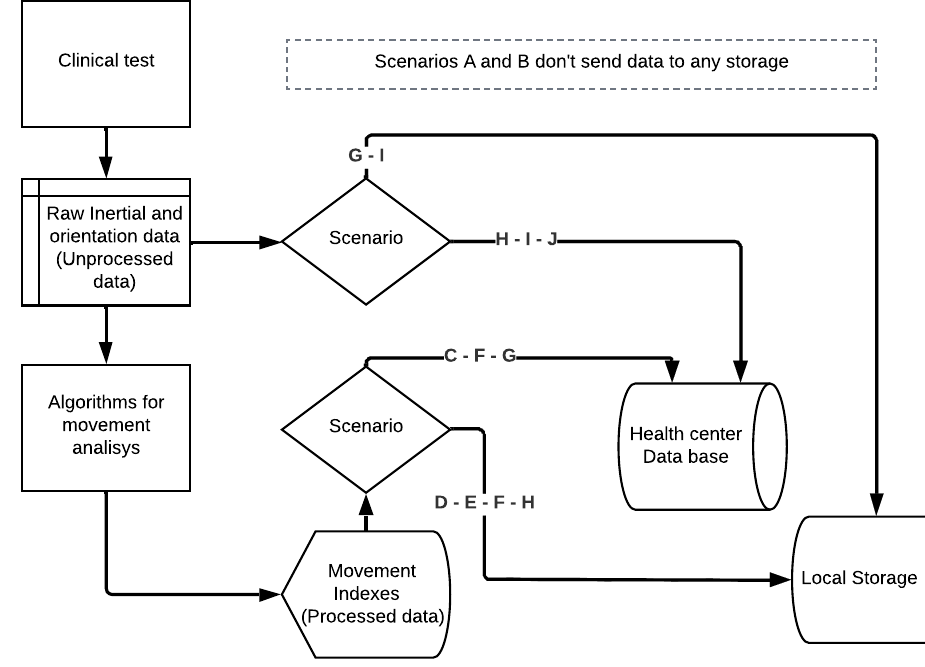
Figure 8. Information flow management depending the scenario selected on the mobile